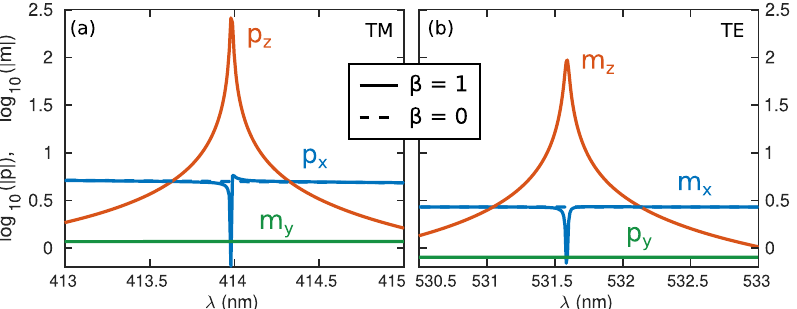
Figure 3: Spectral dependence of the relevant electric and magnetic dipolar moments (in logarithmic scale) on each sphere of an infinite square array of lossless semiconductor ( n = 3 . 5) nanospheres (lattice period a = 300 nm, sphere diameter D = 150 nm) as in Figure 2a illuminated at normal incidence 𝜃 = 0 ◦ , with ( 𝛽 = 1, solid curves), and without ( 𝛽 = 0, dashed curves) MO activity, theoretically calculated through CEMD in the vicinity of each BIC: (a) out-of-plane electric dipole p z and in-plane contributions p x , m y for TM polarization; (b) out of plane magnetic dipole m z and in-plane contributions m x , p y for TE polarization. All of them are normalized by the in-plane electric or magnetic dipole moments ( p y or m y ) that would be excited about an isolated sphere. The out-of-plane dipole moments p z , m z are negligible for 𝛽 =